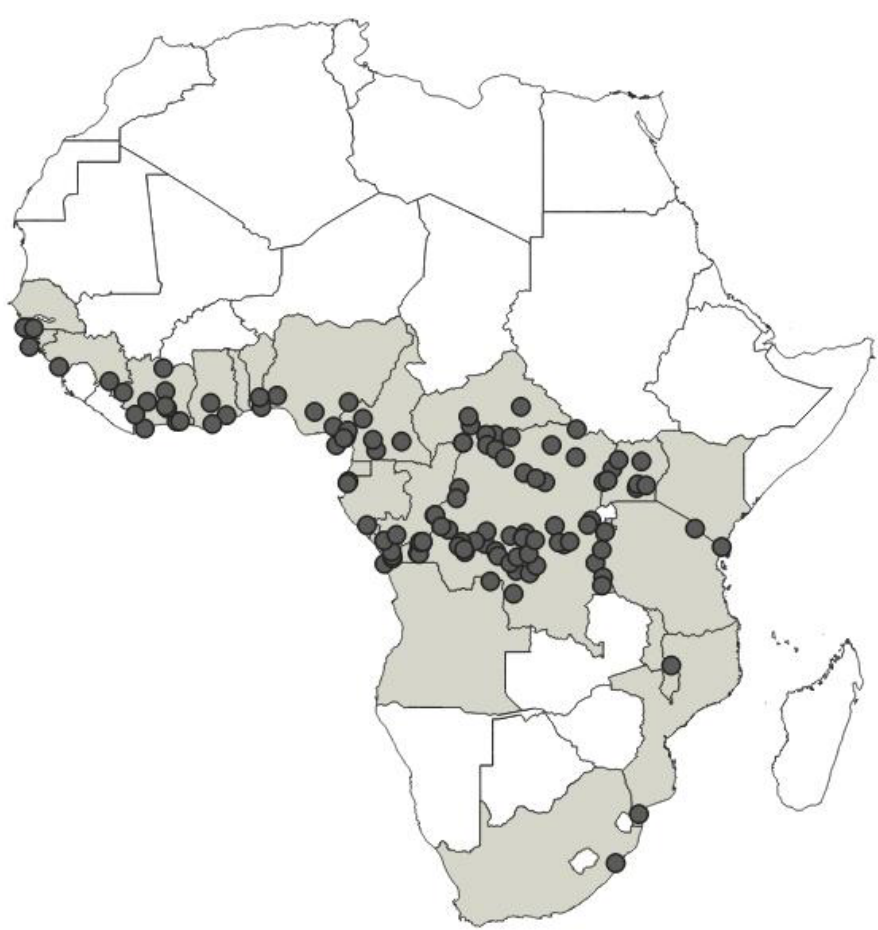
Figure 41. Known distribution of Phonoctonus fasciatus (Beauvois,